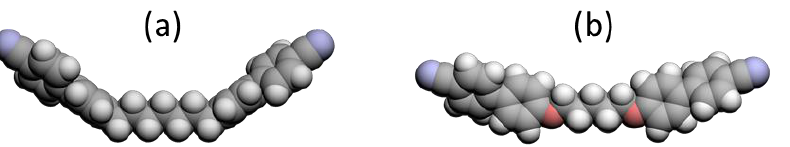
Figure 11. A comparison of the shapes of odd-membered methylene- and ether-linked dimers: ( a ) CB7CB and ( b ) CBO5OCB.